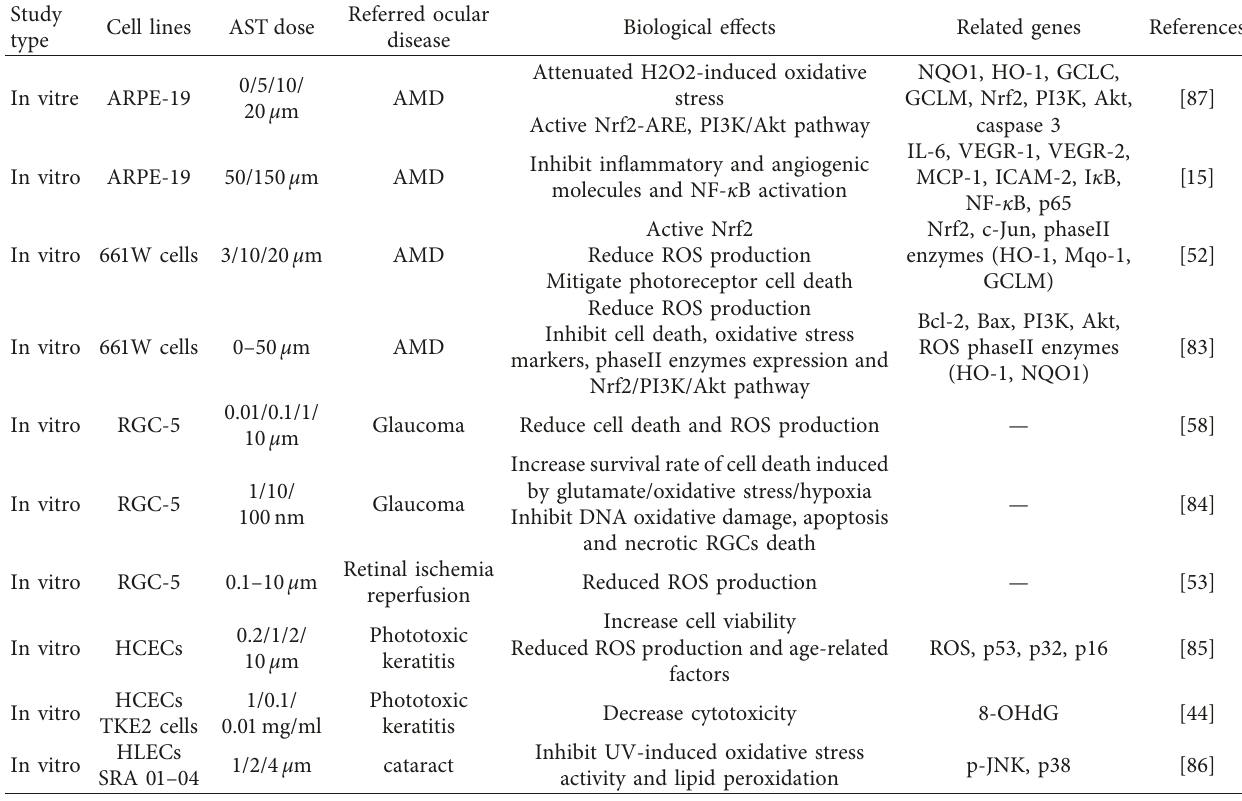
Table 3: Summary of in vitro studies on eye and